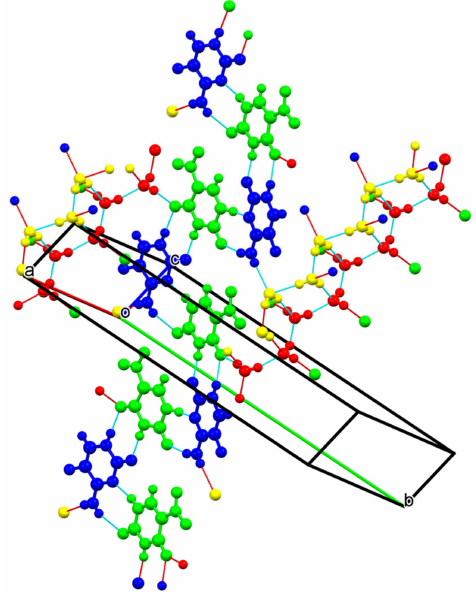
Figure 12. Hydrogen bonded chains in (XI) and ladder formation by water molecules. Different colors portray different residues.